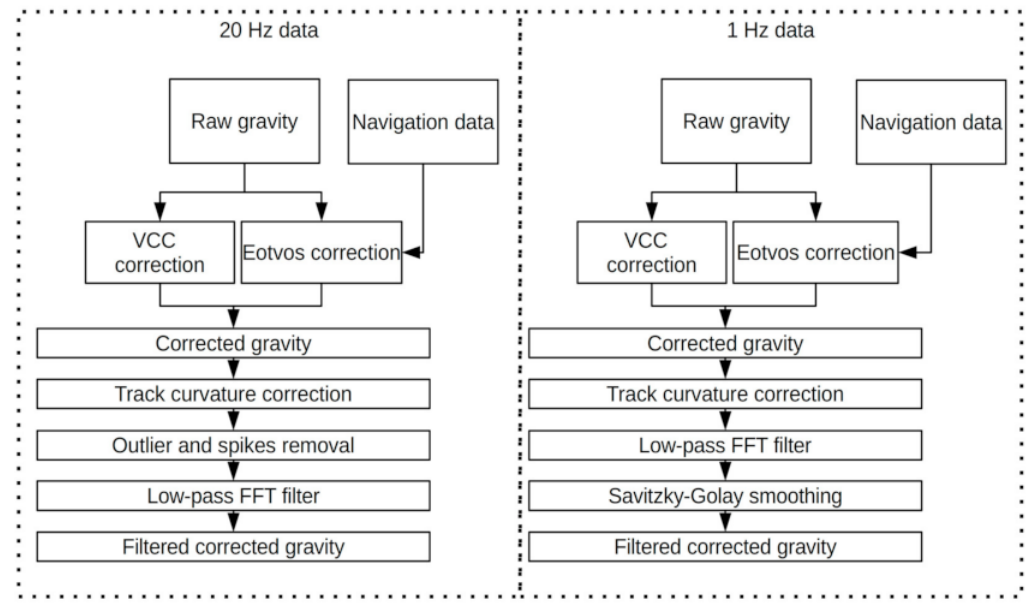
Figure 7. The block scheme showing the data processing routes for 20 Hz and 1 Hz gravimetric data. The FFT refers to Fast Fourier